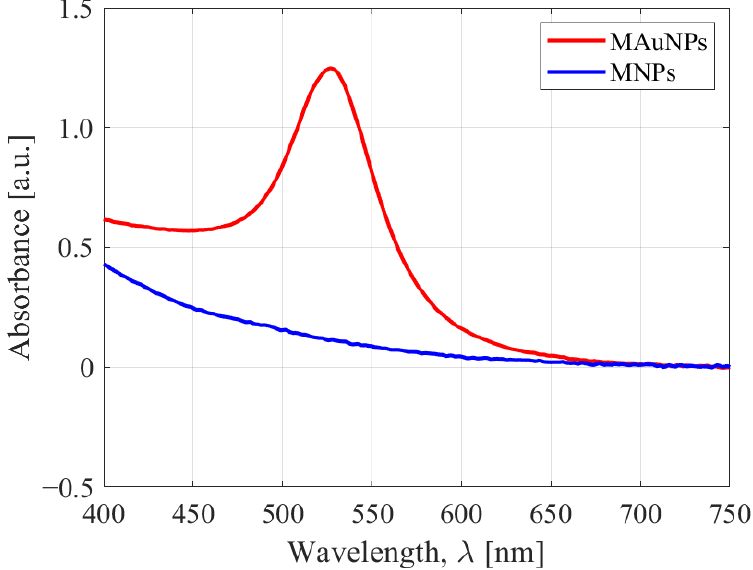
Figure 1. UV − vis spectra of MNPs (blue) and MAuNPs (red). The MAuNP absorbance band is centered around 529 nm.